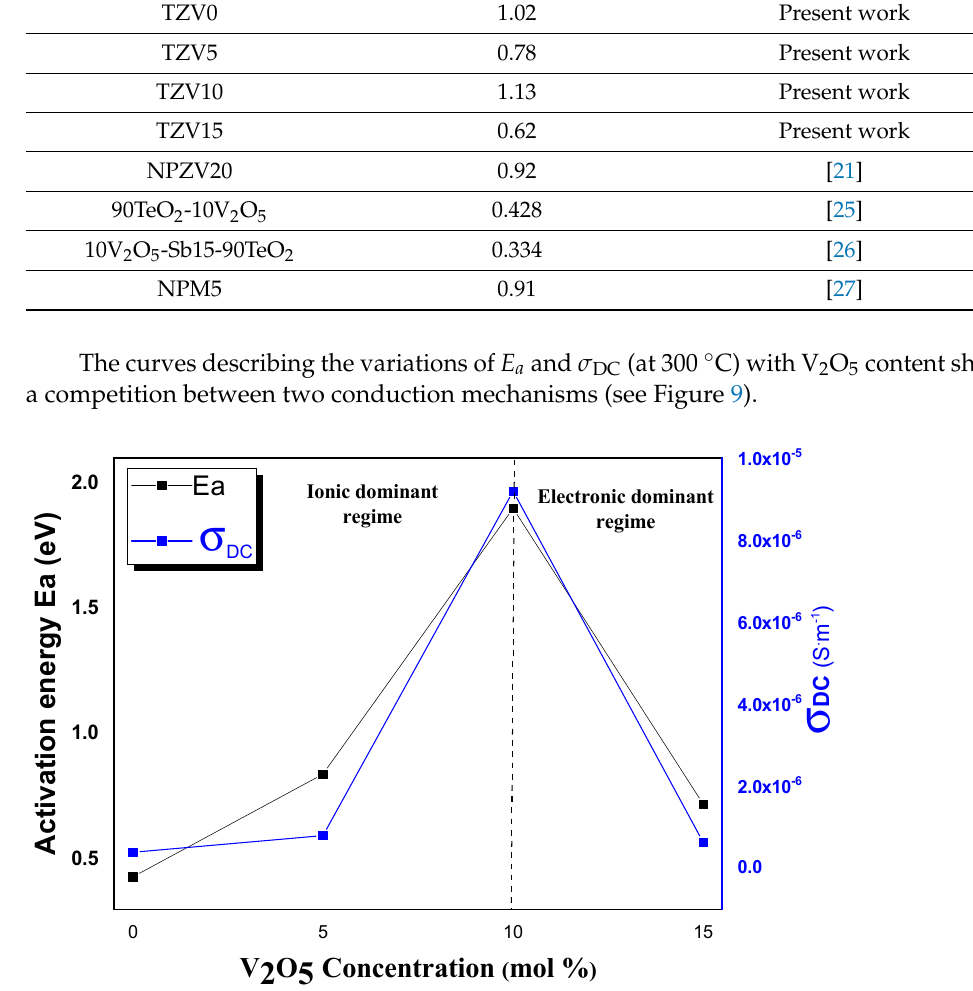
Figure 9. Variation of the activation energy Ea and the conductivity σ DC at 573 K with the V 2 O 5 content in zinc-tellurite glass samples.